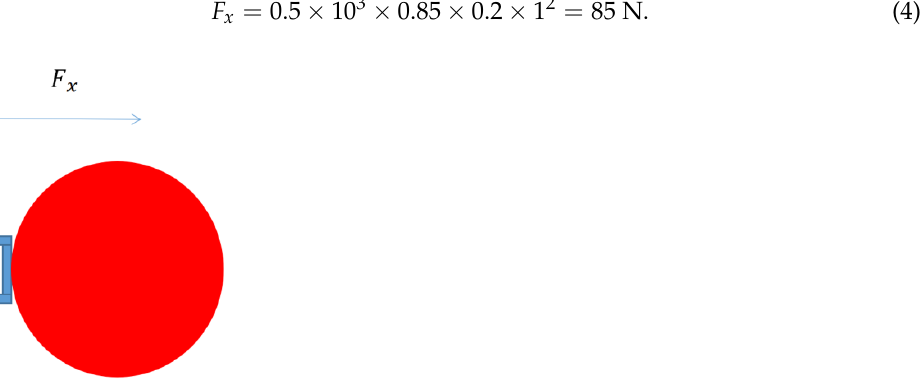
Figure 8. Profile AUV stress in the vertical direction, F y is the water resistance in the vertical direc- tion, f is friction force, F is the propeller thrust .